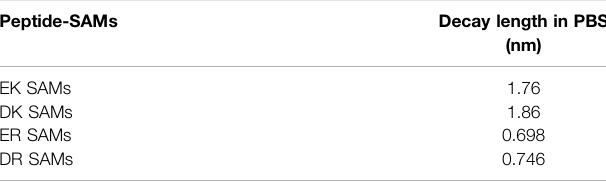
TABLE 5 | Decay lengths of the repulsion acting between the peptide-SAMs in PBS. Peptide-SAMs Decay length in PBS